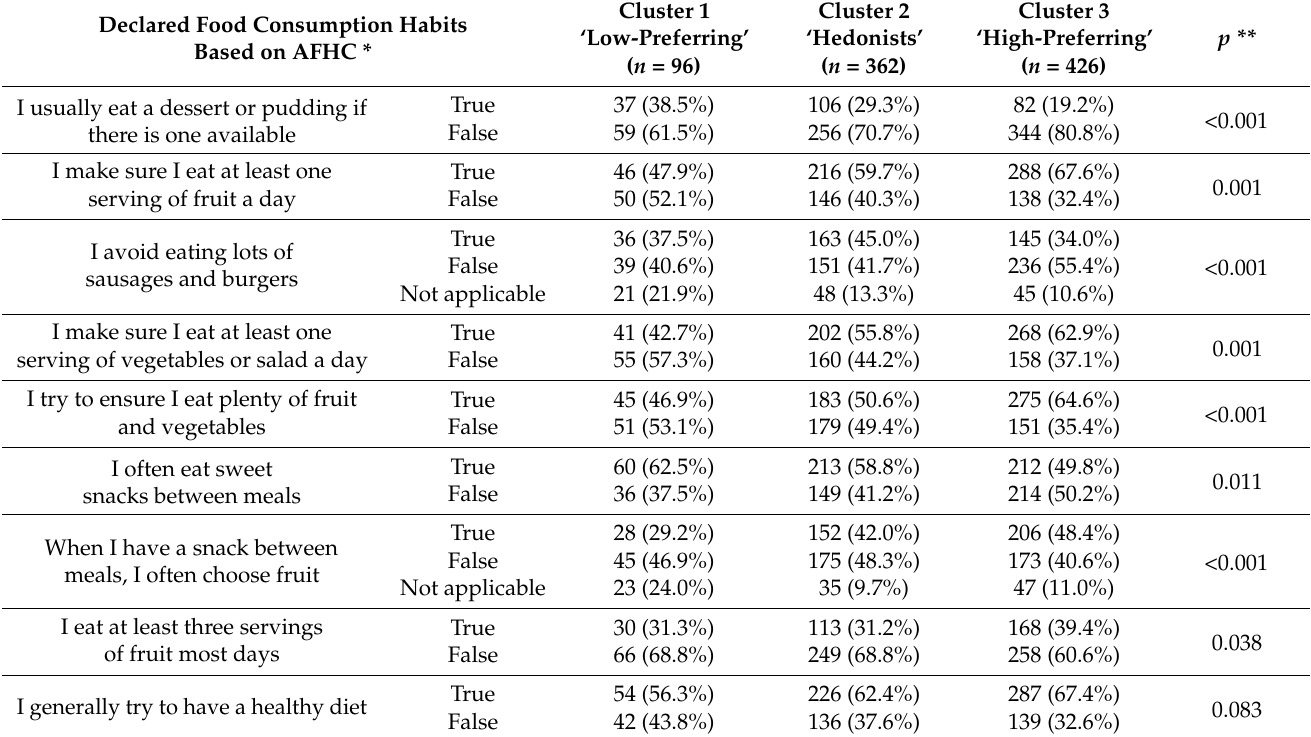
Table 11. The declared food consumption habits assessed based on the Adolescents’ Food Habits Checklist (AFHC) in the clusters stratified based on the preferences assessed while using the Food Preference Questionnaire (FPQ) within the male population of the second phase of the Polish Adolescents’ COVID-19 Experience (PLACE-19) Study ( n = 884). Declared Food Consumption